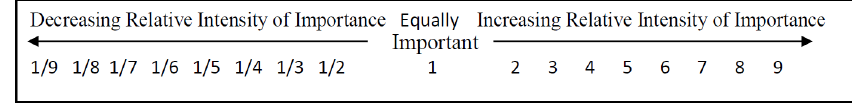
Table 2. AHP scale used in this study.